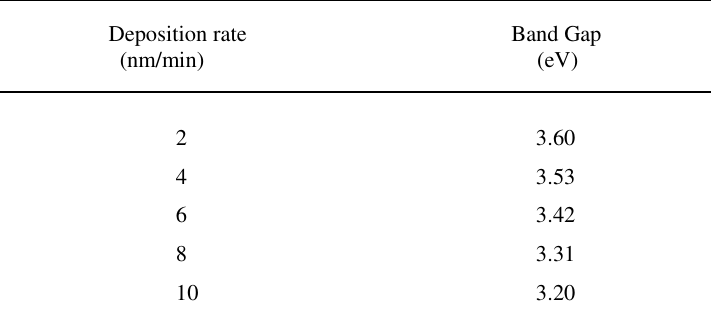
Figure 4. Optical transmission spectra for ITO films prepared at various deposition rates. Table 2. Band gap energy of various